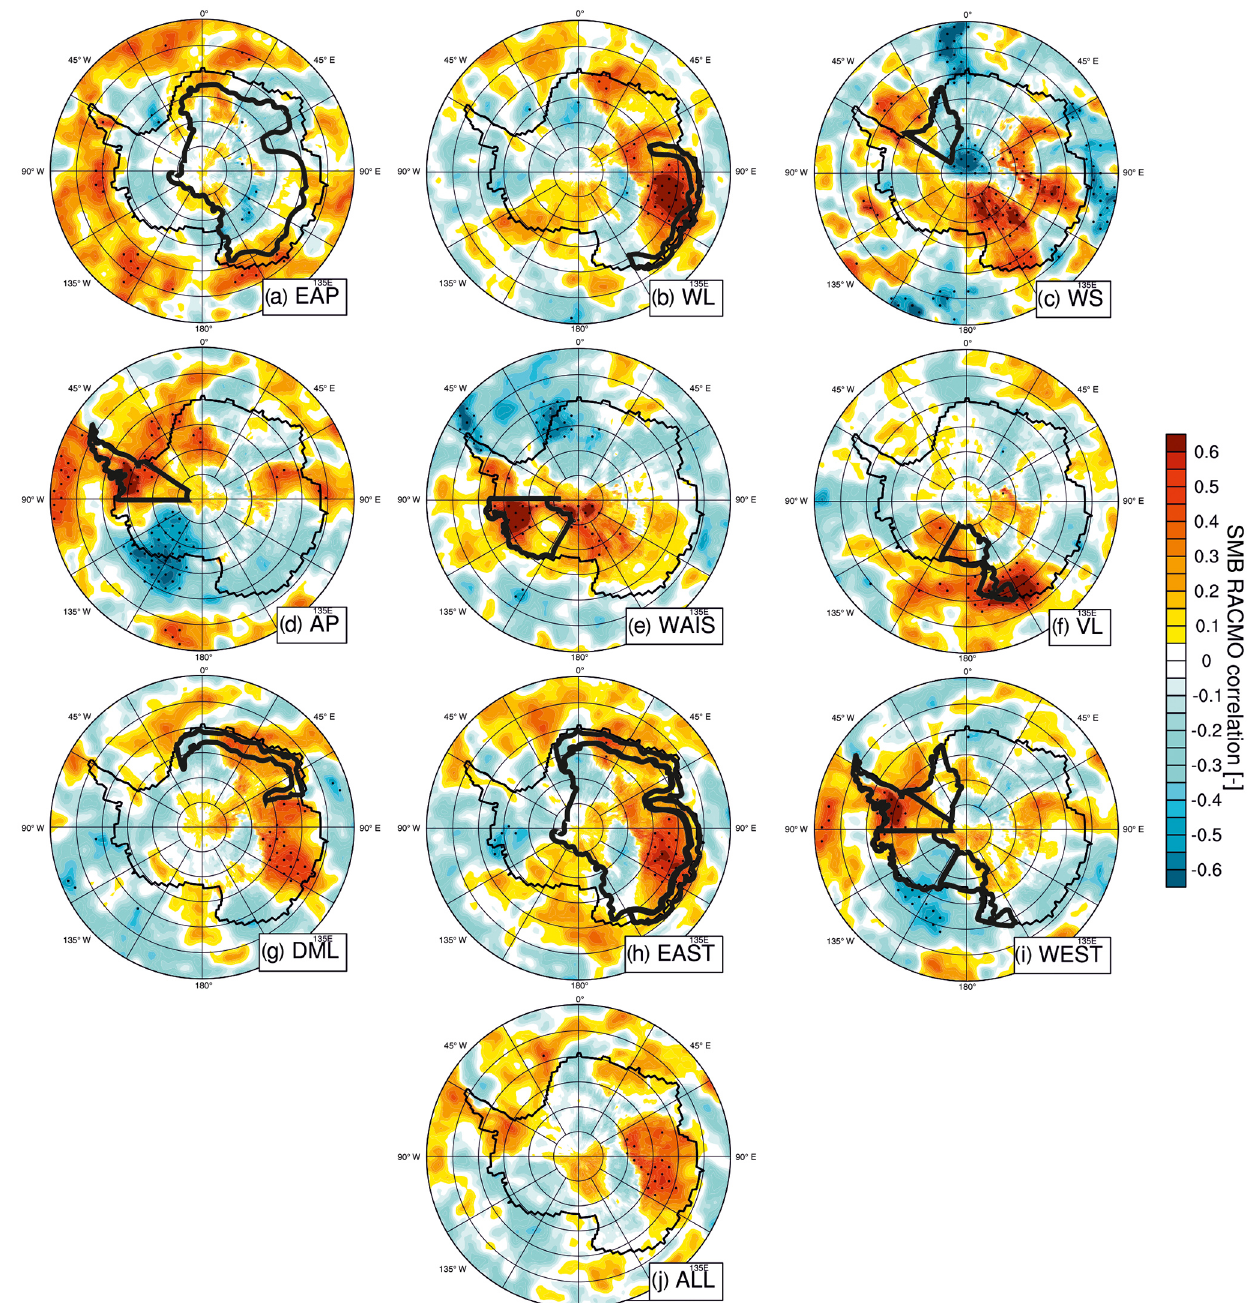
Figure 3. Spatial correlation plots of standardized regional and continental composites of snow accumulation with precipitation from ERA- Interim (1979–2010). Grid points with >95% significance are dotted. Note that correlation with WS only covers the period 1979–1992.